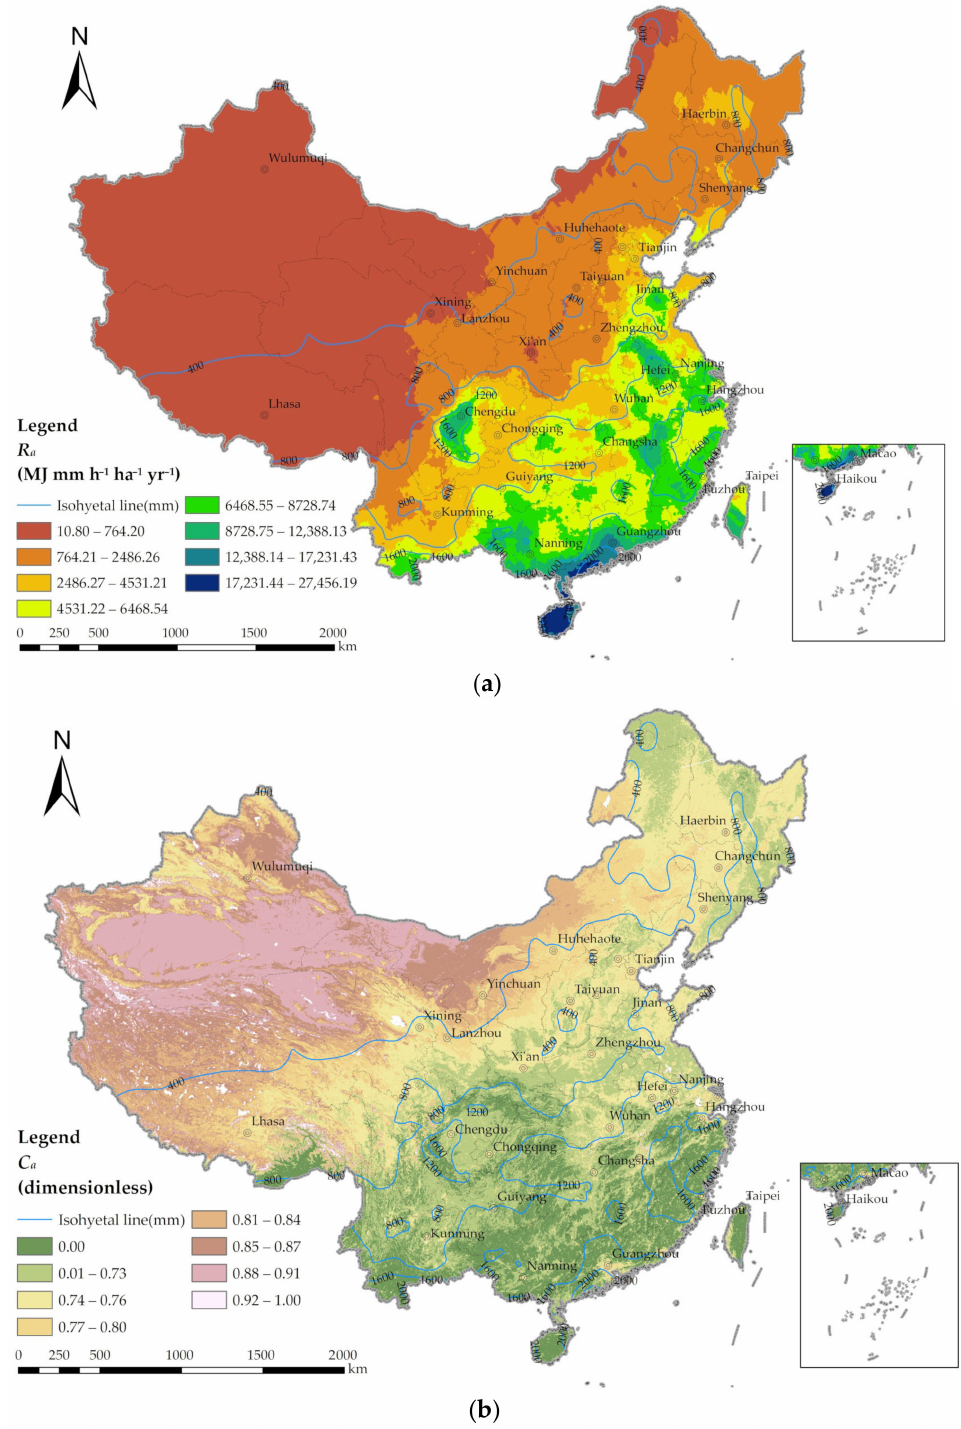
Figure 2. Calculation of the annual cumulative rainfall erosivity ( R a ) and annual land cover and management ( C a ). ( a ) Calculation of R a , ( b ) Calculation of C a